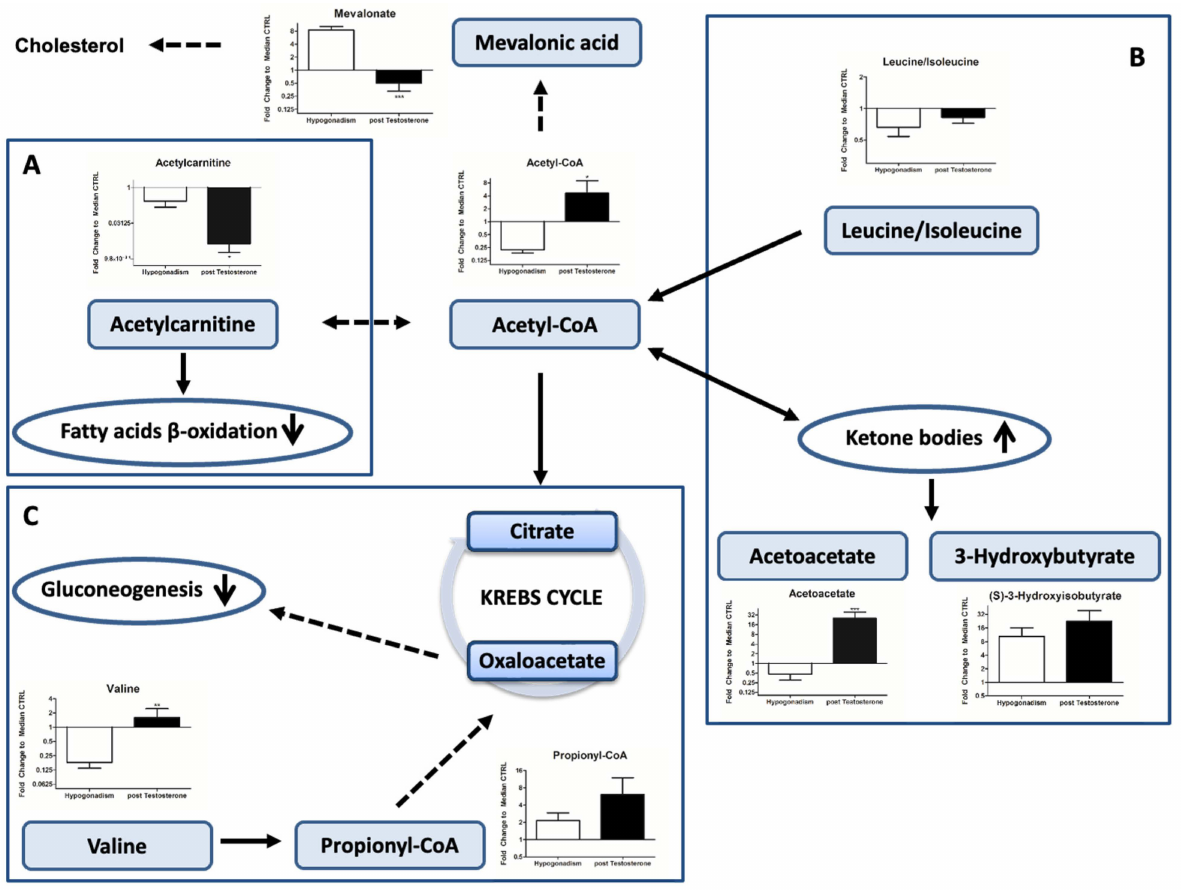
Figure 3. Metabolisms involved in acetyl CoA consumption or production as the main metabolite in glycolytically altered metabolism. Acetyl CoA levels were increased after TRT; instead, low level of acetylcarnitine reported decreased β -oxidation Panel ( A ). Acetyl CoA was mainly converted into ketone bodies Panel ( B ). Finally, high levels of valine and propionyl CoA with low level of oxaloacetate justified decreased gluconeogenesis Panel ( C ). All data are shown as mean ± SEM of fold-change relative to the metabolite levels in controls. * p < 0.05, ** p < 0.01, *** p < 0.001. Of note, most of the acetyl CoA was used to produce ketone bodies, such as acetoac- etate and 3-hydroxybutyrate. A major part of acetyl CoA comes from the degradation of leucine/isoleucine in favor of ketone body formation (Figure 3B). A small percentage of acetyl CoA entered into the Krebs cycle (TCA), which remained inactive (Figure 3C) (as revealed by the low amount of citrate produced (Figure 4)). Moreover, oxaloacetate (OAA), the main precursor of gluconeogenesis, was not produced (Figure 4) from amino acids, indicating that gluconeogenesis, the main energy source in IR hypogonadism [17] was no longer active upon TRT. As a result, although the glycerol shuttle was re-activated upon TRT, the total NAD and NADH was significantly low (Figure 5A), as well as ATP levels (Figure